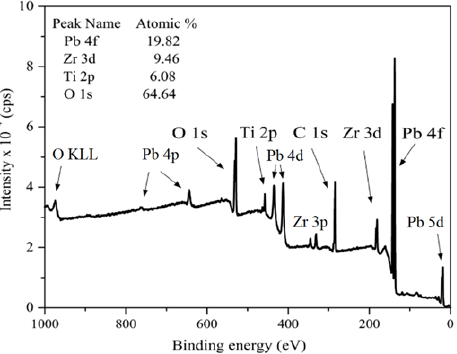
Figure 6. Wide-scan XPS spectra of the deposited at 550 °C substrate temperature PZT films.